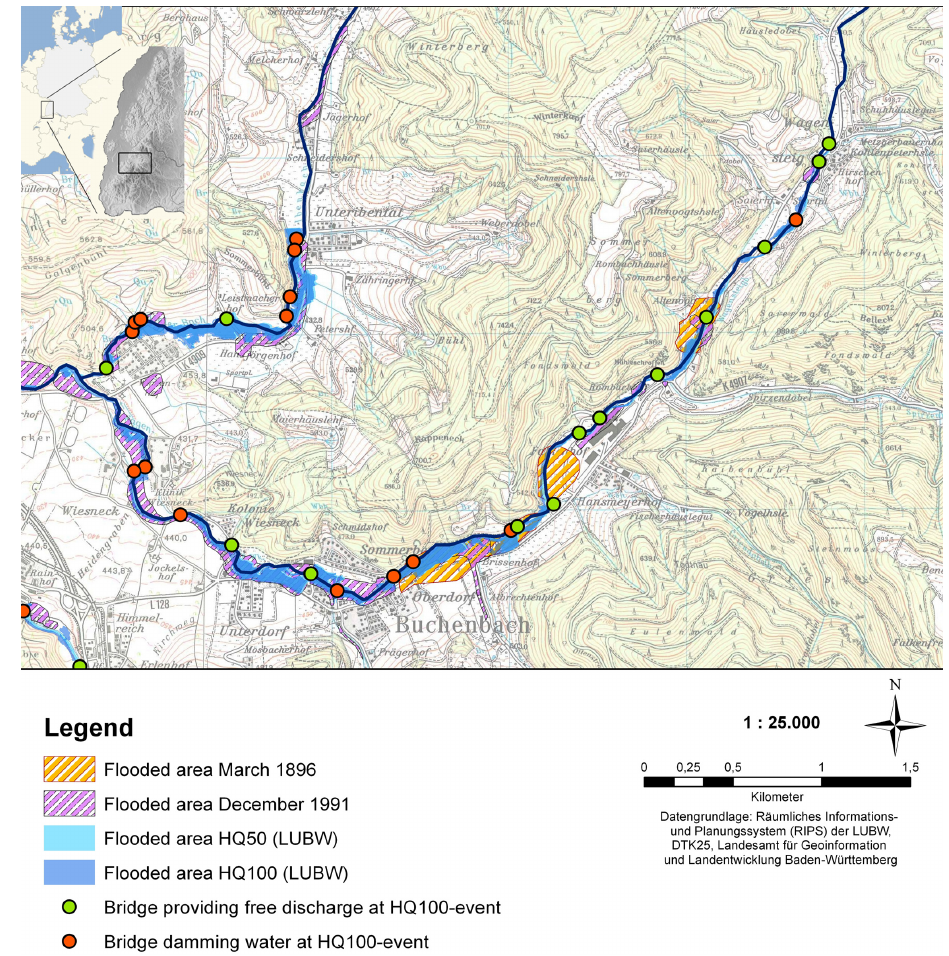
Figure 15. Comparison of flooded areas of 1896 and 1991 with modern HQ50 and HQ100 inundation areas as published by LUBW as part of the EU water directive (EU,